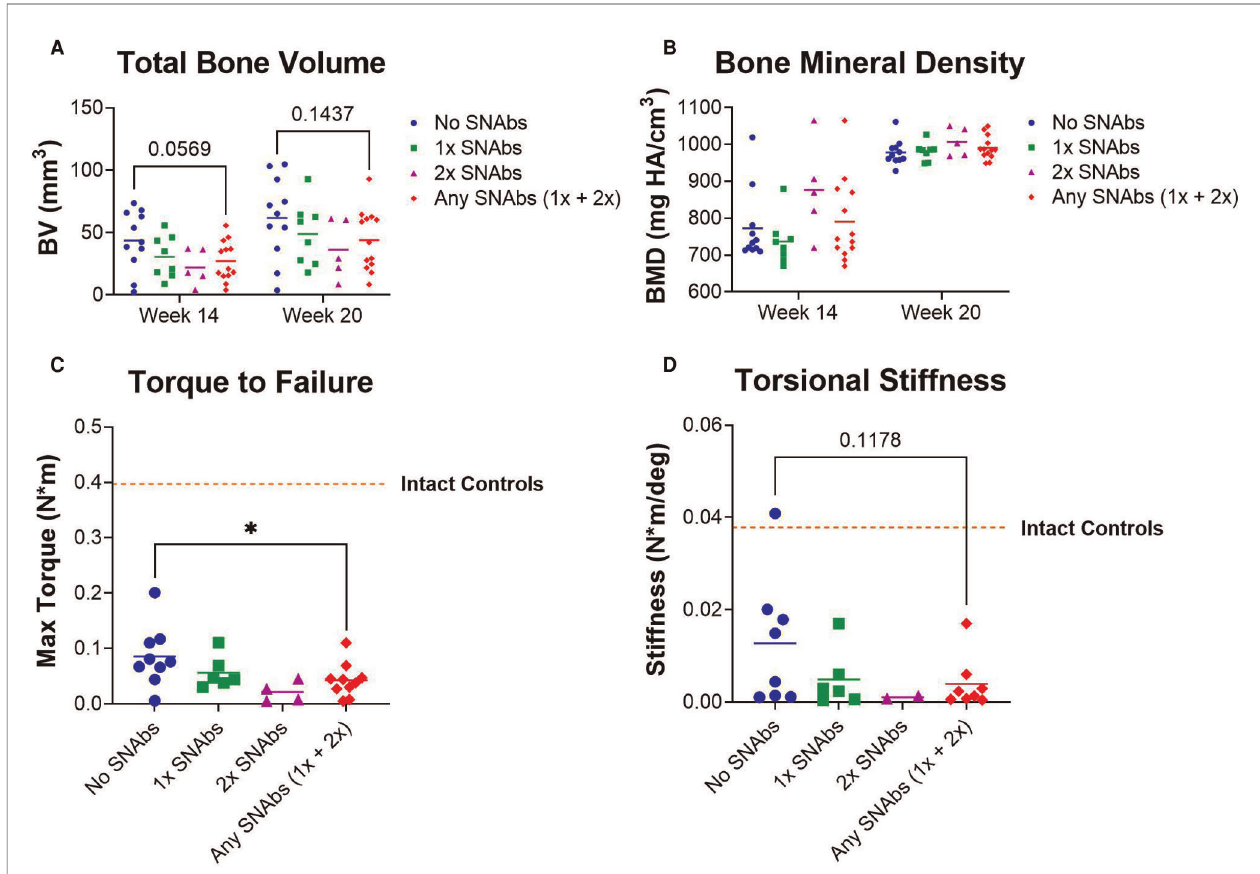
FIGURE 5 | Functional regeneration may be impaired following treatment with synthetic nanoparticle antibodies (SNAbs). ( A,B ) Total bone volume ( A ) and bone mineral density ( B ) of newly formed bone, as quanti fi ed by in vivo µCT at week 14 and ex vivo µCT at week 20. ( C,D ) Mechanical strength ( C ) and stiffness ( D ) of regenerated femurs as quanti fi ed by ex vivo torsional testing to failure at week 20. The dotted lines indicate mechanical properties of intact bone. * P <0.05 as